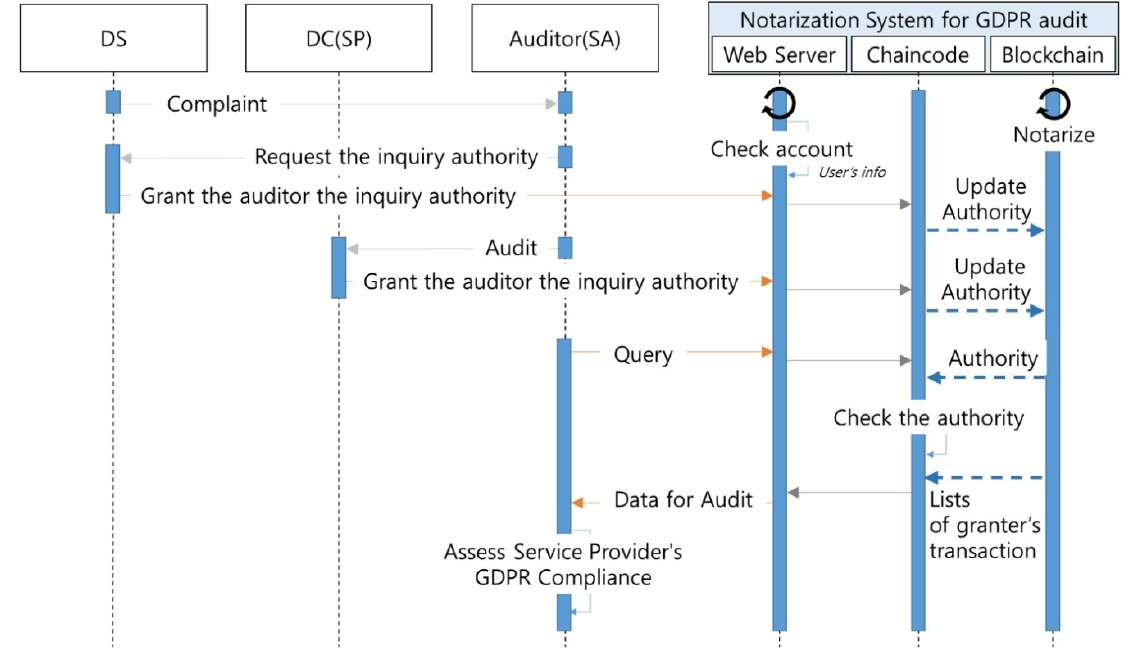
Figure 10. GDPR compliance audit process. Algorithm 5 is an algorithm for the smart contract implement of granting inquiry authority in Figure 10. Algorithm 5 Input Authority